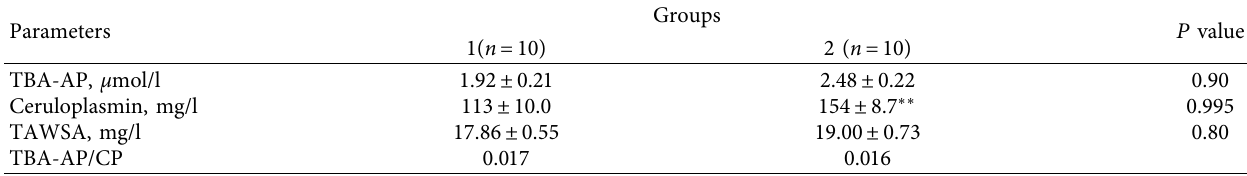
Table 2: Indicators of lipid peroxidation and antioxidant protection in the body of sows after weaning.